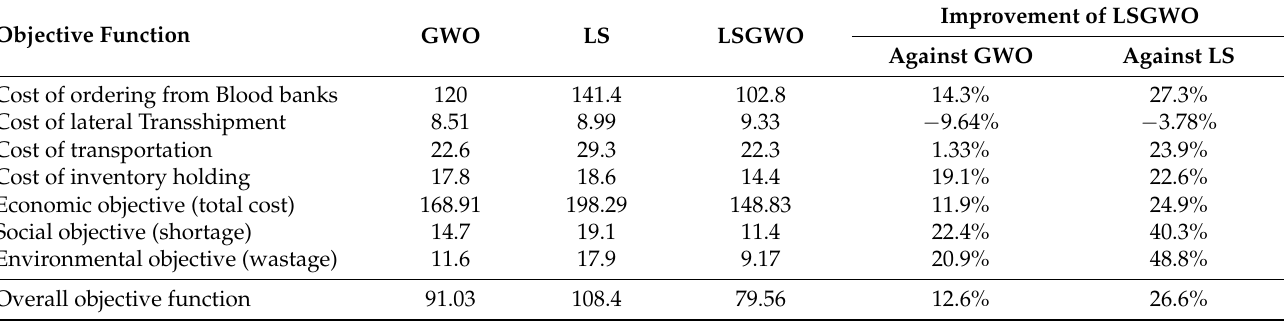
Table 4. Detailed results of the objective function for different methods (in